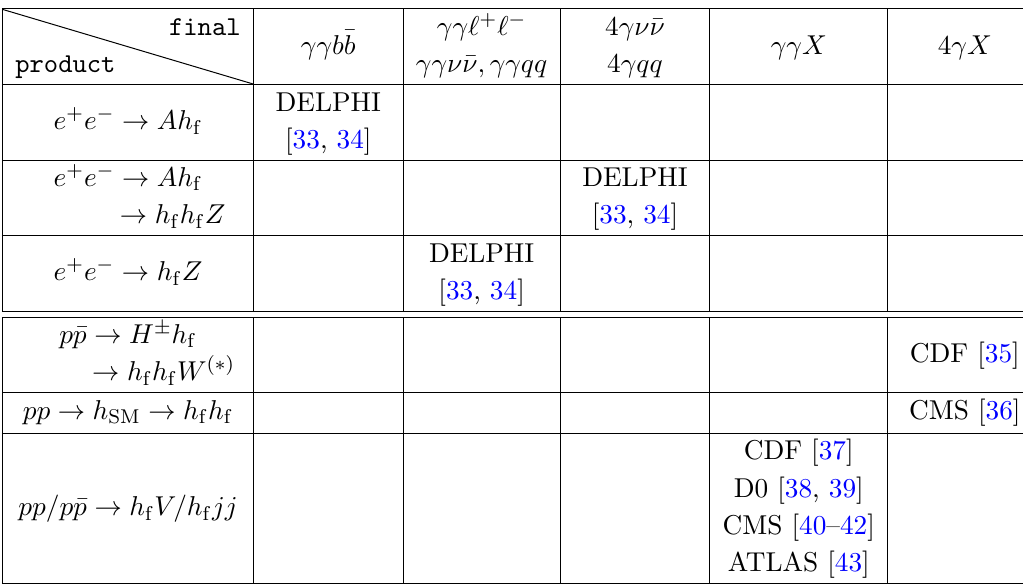
Table 1 . Experimental searches for a fermiophobic Higgs boson at the LEP, Tevatron, and LHC. We classify the processes according to the production channel and the final